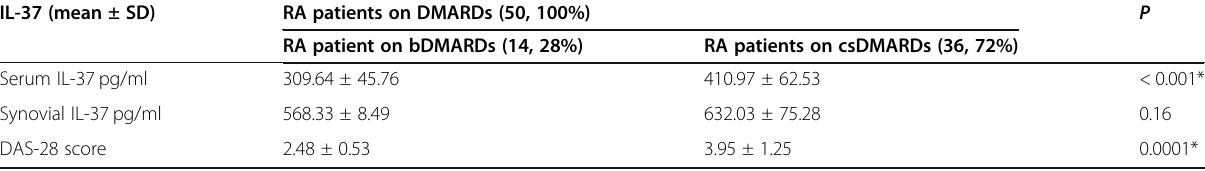
Table 5 Comparison between the mean serum and synovial IL-37 levels in the RA group according to the medications IL-37 (mean ± SD) RA patients on DMARDs (50, 100%)